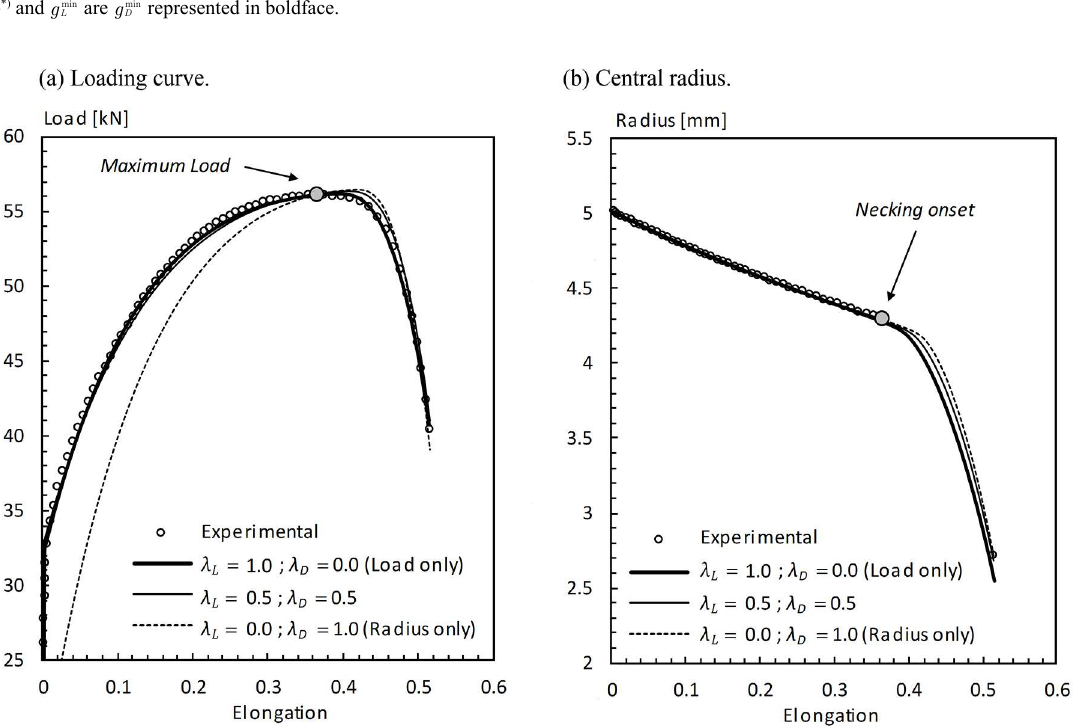
Figure 2. Modified Voce's yield stress equation : evolution of the tensile load and specimen central